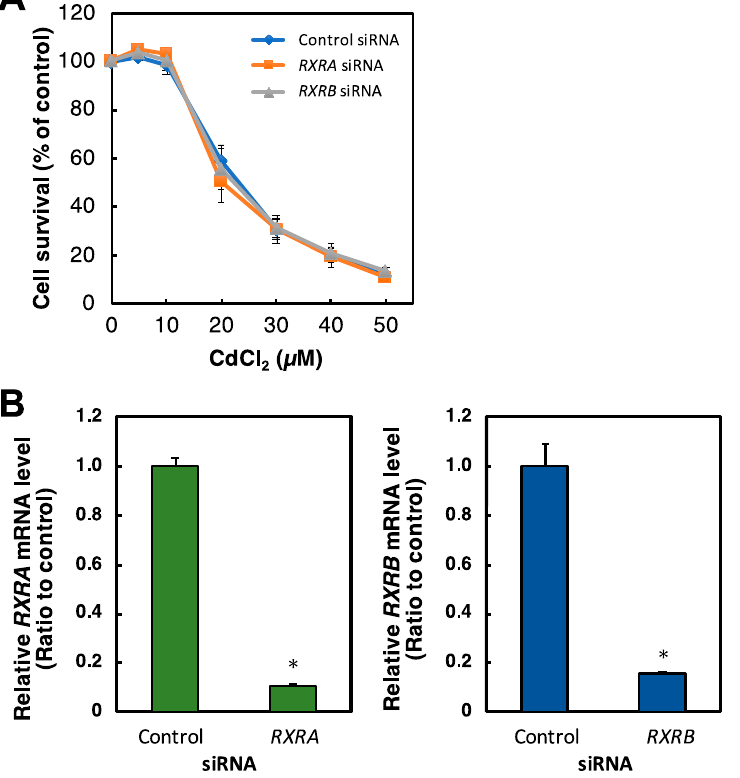
Figure 4. Effect of RXR knockdown on the survival rate of HK-2 cells treated with Cd. ( A ) After treatment with siRNA against the gene of RXRA or RXRB for 48 h, HK-2 cells were treated with Cd for 24 h. Cell survival was examined by the Alamar blue assay. Values are means ± SD ( n = 3). * Significantly different from the control siRNA group, p < 0.05. ( B ) Efficiency of RXRA and RXRB knockdown was examined after HK-2 cells were treated with siRNA the gene of RXRA or RXRB for 48 h. RXRA and RXRB mRNA levels were examined by real-time RT–PCR and normalized to GAPDH mRNA levels. Values are means ± SD ( n = 3). * Significantly different from the control group, p < 0.05.